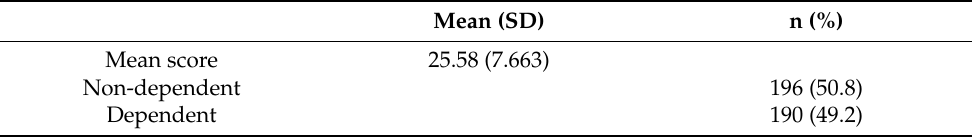
Table 6. The mean score and prevalence of screen